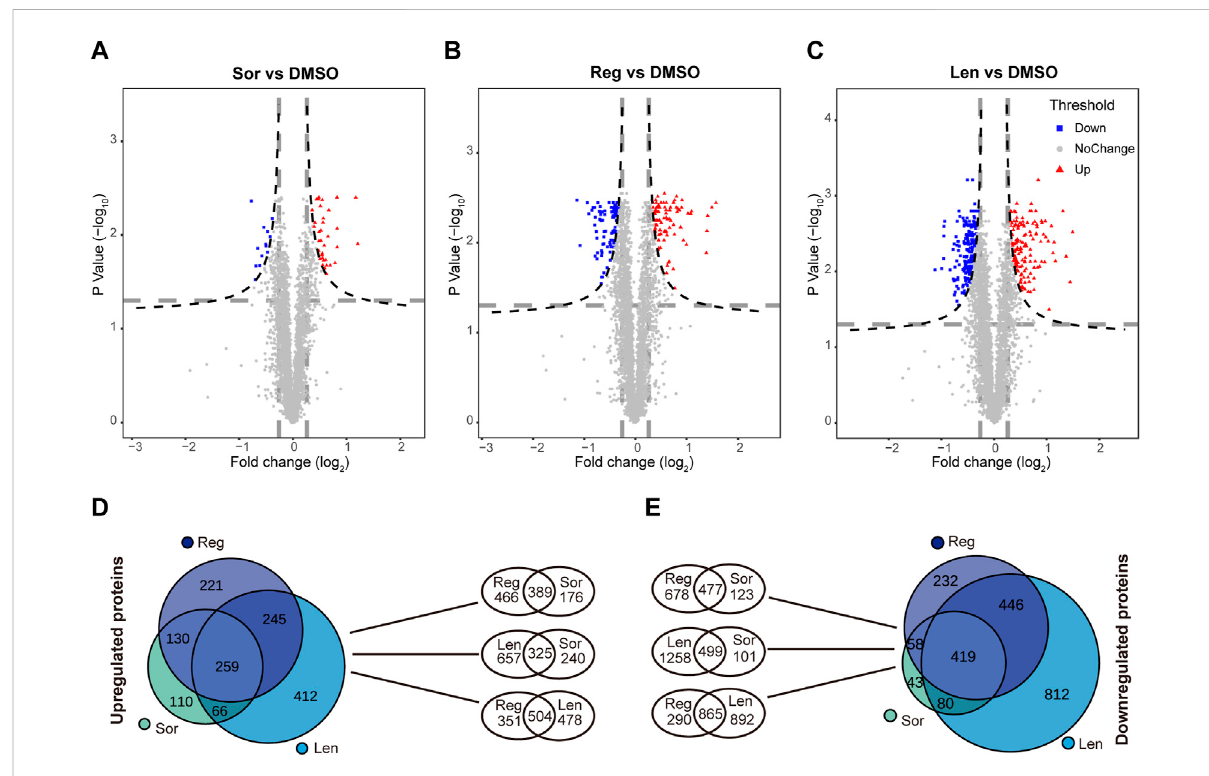
FIGURE 5 Volcano plots of signi fi cantly altered proteins in Huh-7 cells treated by 72 h incubation with respective sorafenib (Sor), (A) , lenvatinib (Len), (B) and regorafenib (Reg), (C) attheir IC 50 when compared with 0.1 ‰ DMSO. Venn diagrams show the comparison among the upregulated proteins (D) and the downregulated proteins (E) in Huh-7 cells treated by Sor, Len and Reg at their IC 50 .